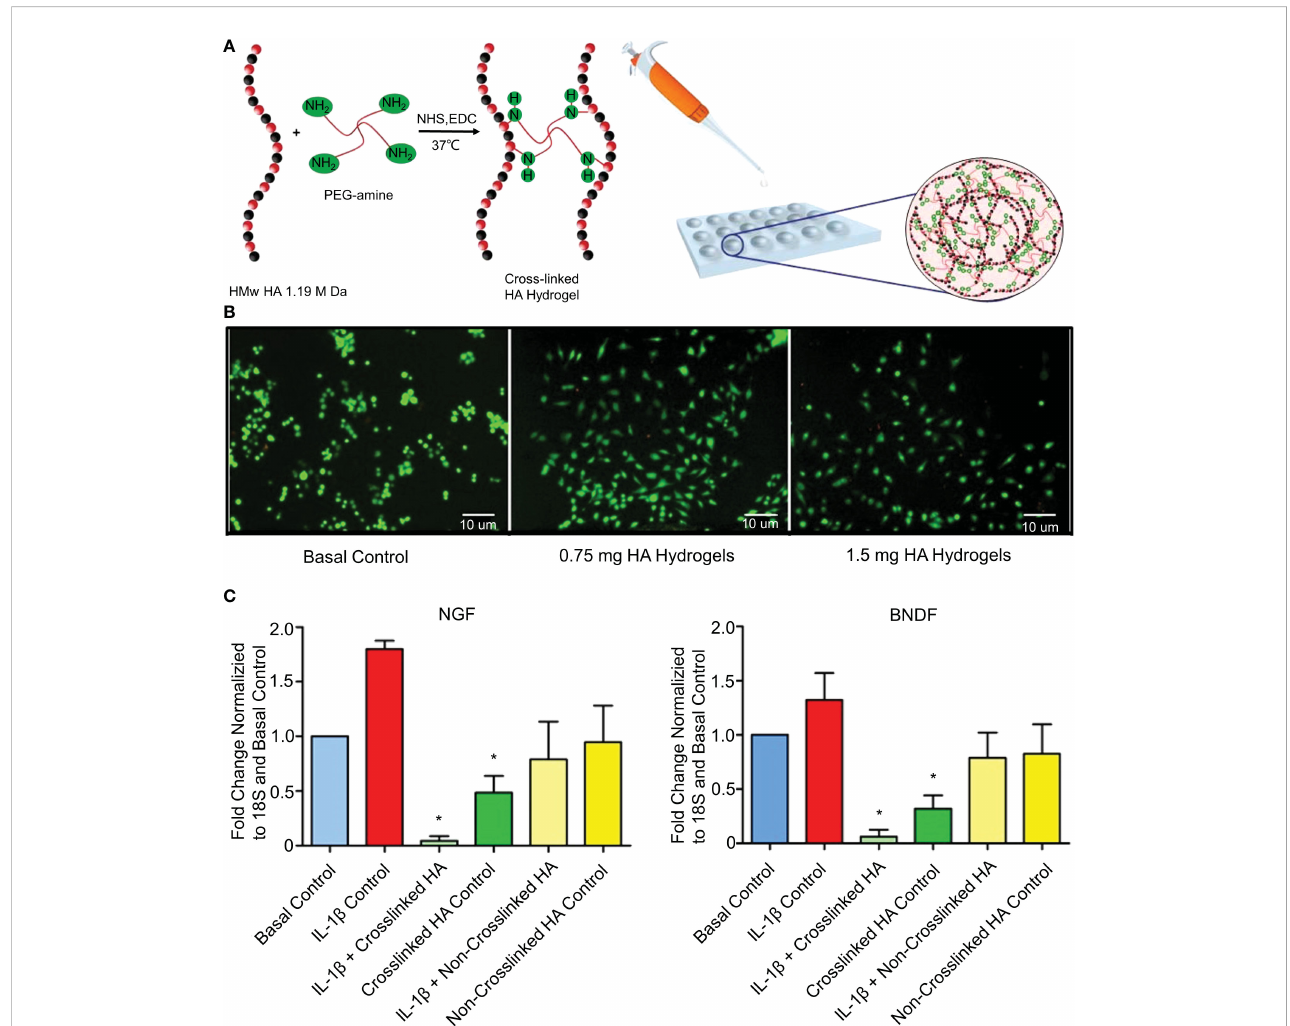
FIGURE 3 (A) Schematic diagram of the synthesis of the cross-linked HA hydrogel system. (B) Stained NP cell morphology by the LIVE/DEAD assay after 3 days of culture in the presence of hydrogels containing different doses of HA. Live cells are green (calcein staining) and dead cells are red (ethidium bromide staining). (C) Fold changes of NGF and BNDF downregulated in IL-1 b -induced in fl ammation and normal NP cells treated with cross-linked HA hydrogels for 7 days. Reproduced with permission from (46). *Indicates signi fi cant difference at a 99 %con fi dence